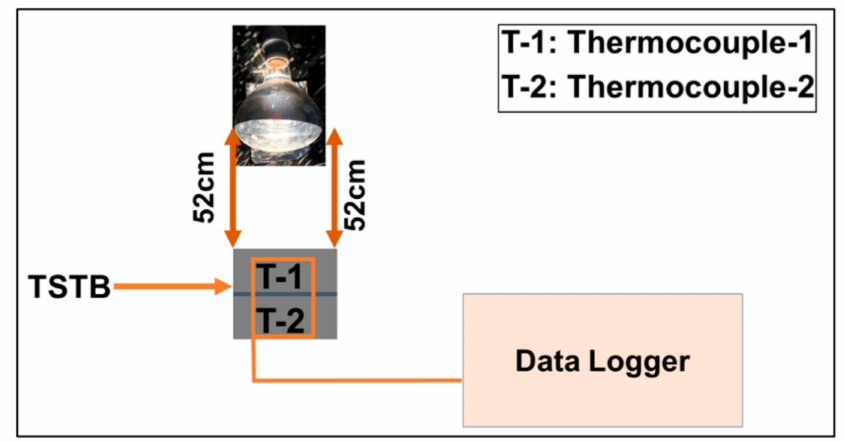
Figure 5. Schematic diagram for the thermal analysis of TSTBs.